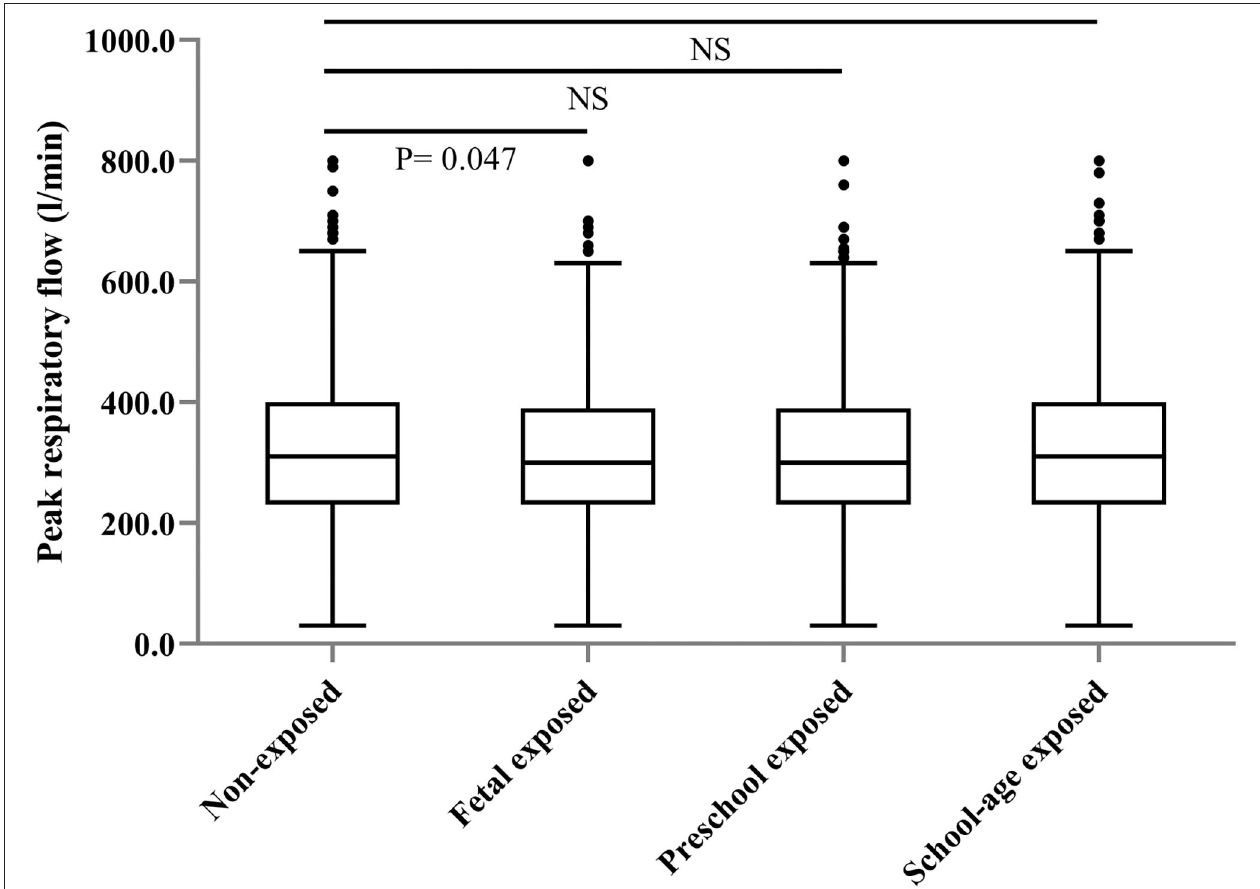
FIGURE 2 | Distribution of peak respiratory flow level among the participants according to the different famine-exposure